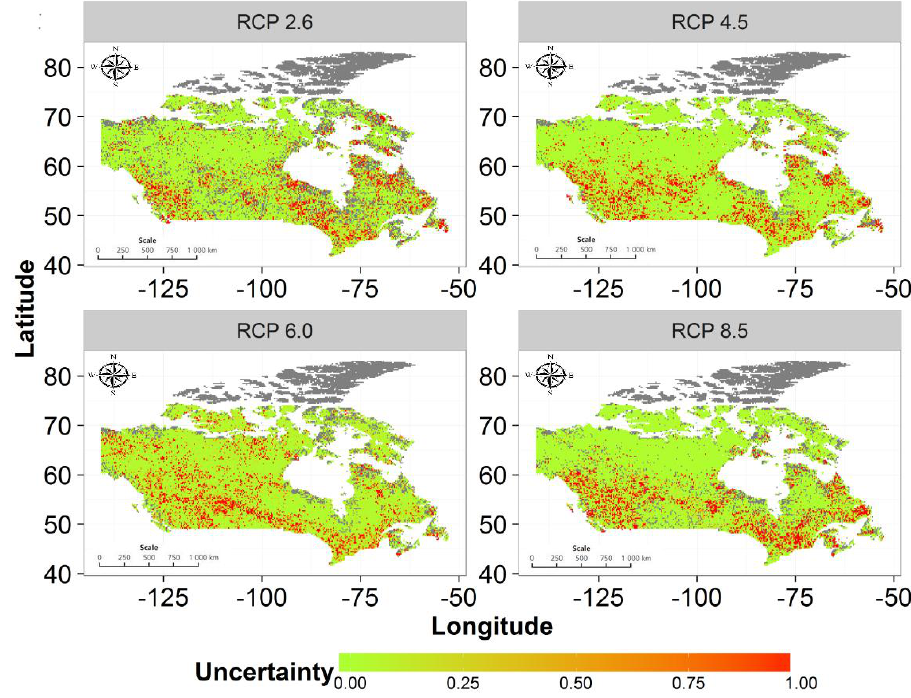
Figure 5. Normalized values of uncertainties obtained for different regions of Canada for 100-year return period flooding events when GCM projections are aggregated using a robust GCM median approach.